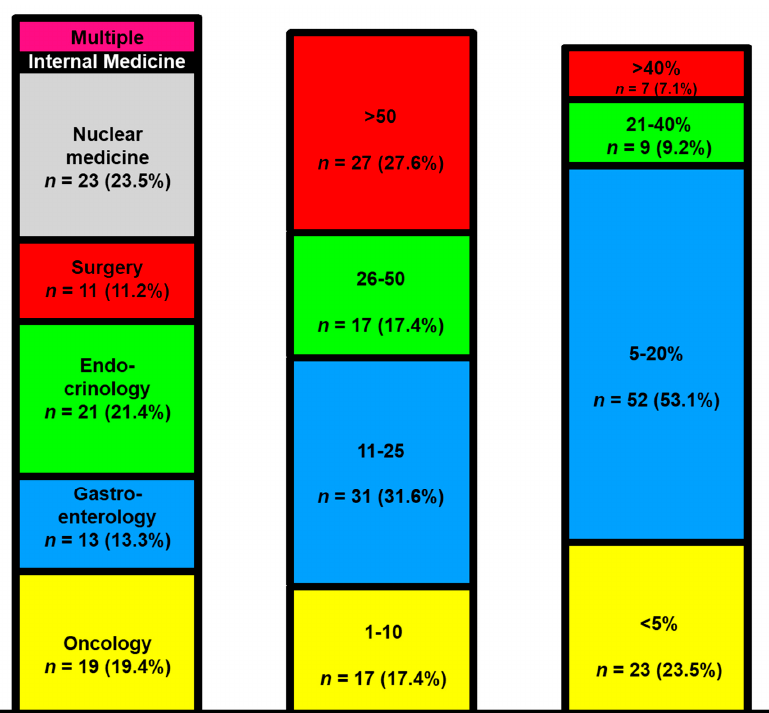
Figure 1. The survey responder disciplines ( left column), treated pancreatic neuroendocrine tumor (NET) patients per year ( middle column), and the time invested in NET care ( right column).